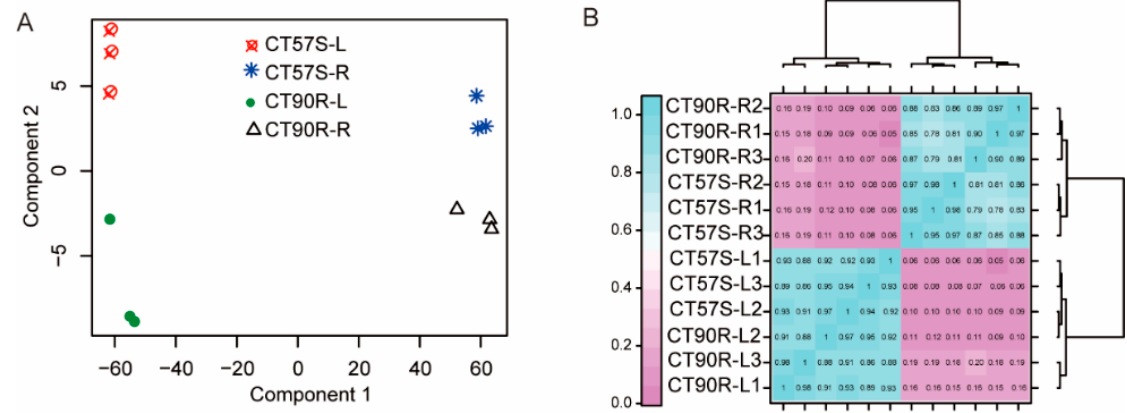
Figure 2. Evaluation of sequencing quality by ( A ) Principal component analysis (PCA) and ( B ) Correlation heat map between samples. CT57S-L, CT57S-leaf; CT57S-L1, the first replicate of CT57S-L; CT57S-R, CT57S-root; CT57S-R1, the first replicate of CT57S-R. The numbers in the heatmap indicate R 2 value in the correlation analysis.